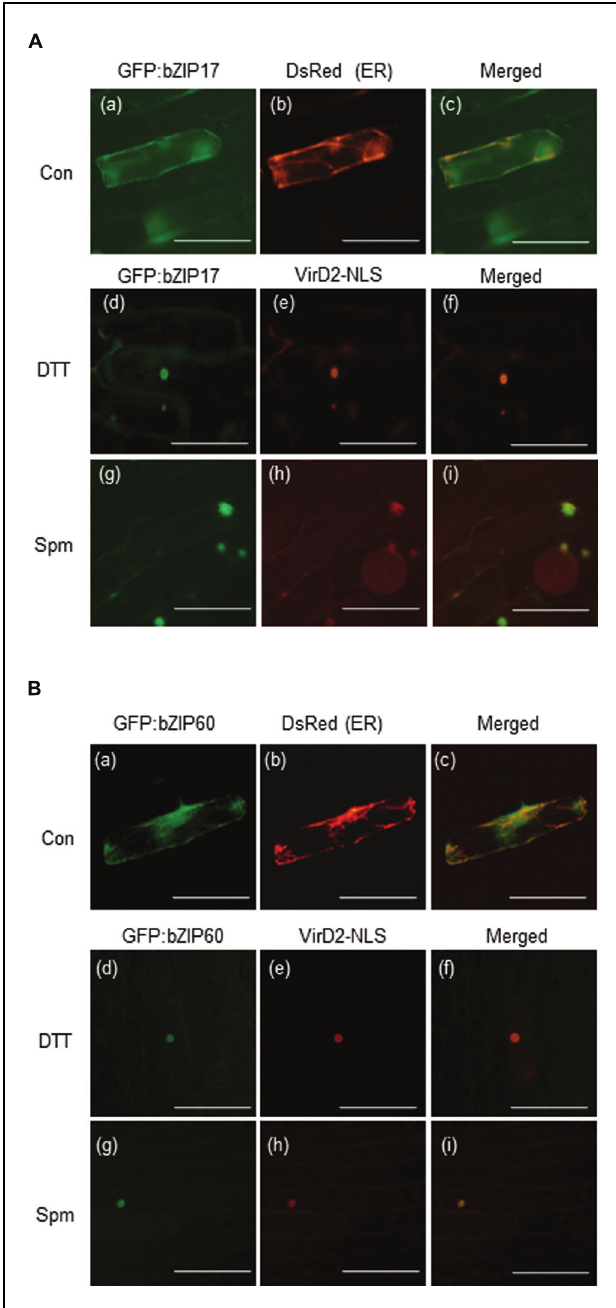
FIGURE 5 | Recruitment of bZIP17 and bZIP60 proteins from ER to nucleus upon Spm treatment. (A) GFP:bZIP17 fusion protein under normal condition (a–c); DTT treatment (d–f); and Spm treatment (g–i). (B) GFP:bZIP60 fusion protein under normal condition (a–c); DTT treatment (d–f); and Spm treatment (g–i). The plasmids encoding GFP:bZIP17 and GFP:bZIP60 proteins were co-bombarded to onion bulbs with the plasmid encoding an ER marker peptide tagged with Ds-Red or with the plasmid encoding a nuclear marker protein VirD2_NLS using a particle gun. The bombarded samples were treated with or without Spm for 16 h under darkness at 22 ◦ C. The samples were also treated with DTT as a positive reference. Then onion epidermal cell layers were peeled off and observed by a fluorescence microscope (BX61; Olympus). Bar indicates 10 µ